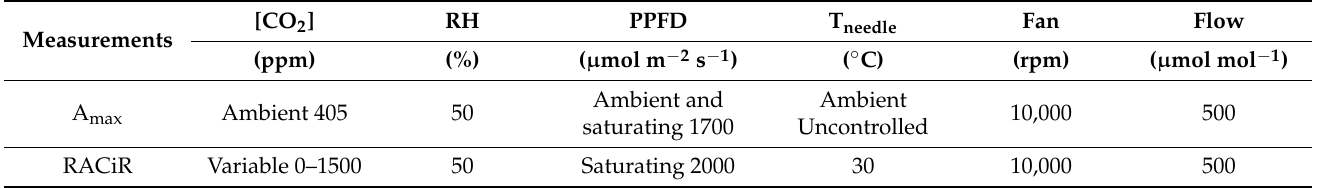
Table 1. Configuration of the LI-6800 when taking data for ecophysiological measurements. [CO 2 ]: CO 2 concentration; RH: relative humidity; PPFD: photosynthetic photon flux density, Tneedle: temperature of sampled